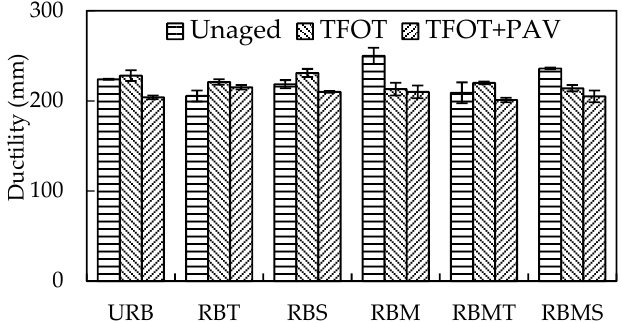
Figure 8. E ff ect of modification methods on the ductility of rubberized bitumen. Figure 8. Effect of modification methods on the ductility of rubberized bitumen.